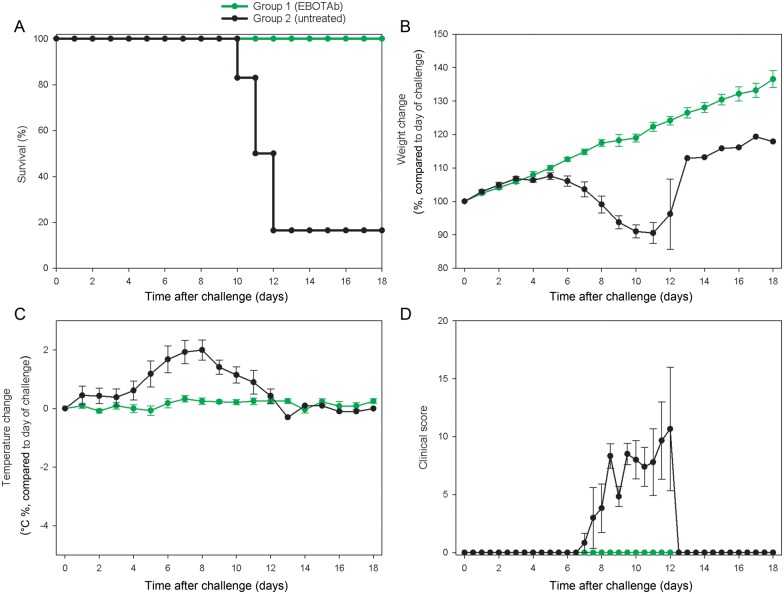
Survival and clinical overview of guinea pigs treated with EBOTAb 6 hours after challenge. Guinea pigs were challenged with Ebola virus (EBOV), and 25 mg of EBOTAb was administered intravenously in a volume of 0.5 mL 6 hours after challenge, followed by daily dosing until day 6 and dosing every 2 days until day 12 (group 1). Untreated animals received no compound (group 2). A, Survival analysis between the EBOTAb-treated group and untreated animals. B, Weight changes, showing percentage differences from values on the day of challenge. C, Temperature differences in animals compared to baseline taken on day of challenge. D, Clinical scores of animals after challenge. In panels B–D, mean results are shown for animals still surviving in all groups, with error bars denoting standard errors.